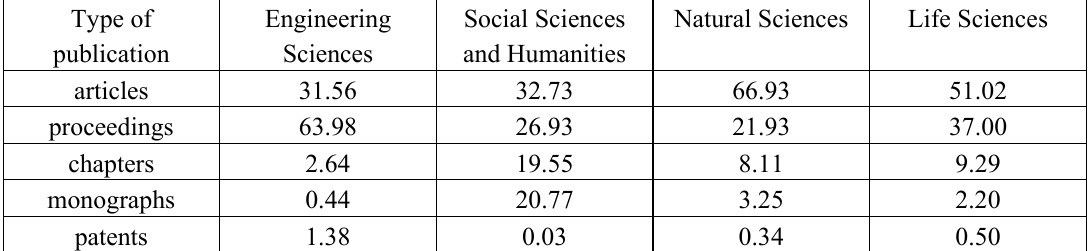
Table 2. Structure of different types of publications in the main scientific fields in Slovenia (in %)—period: 1990–2012 (source: